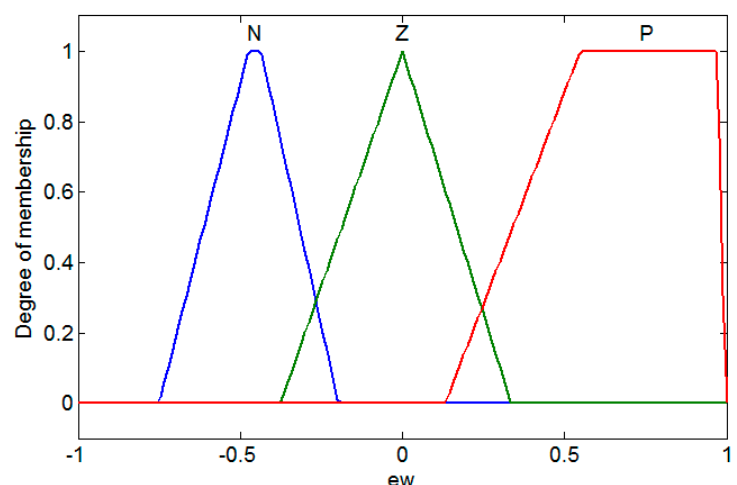
Figure 19. Output 1 optimized by DSO.